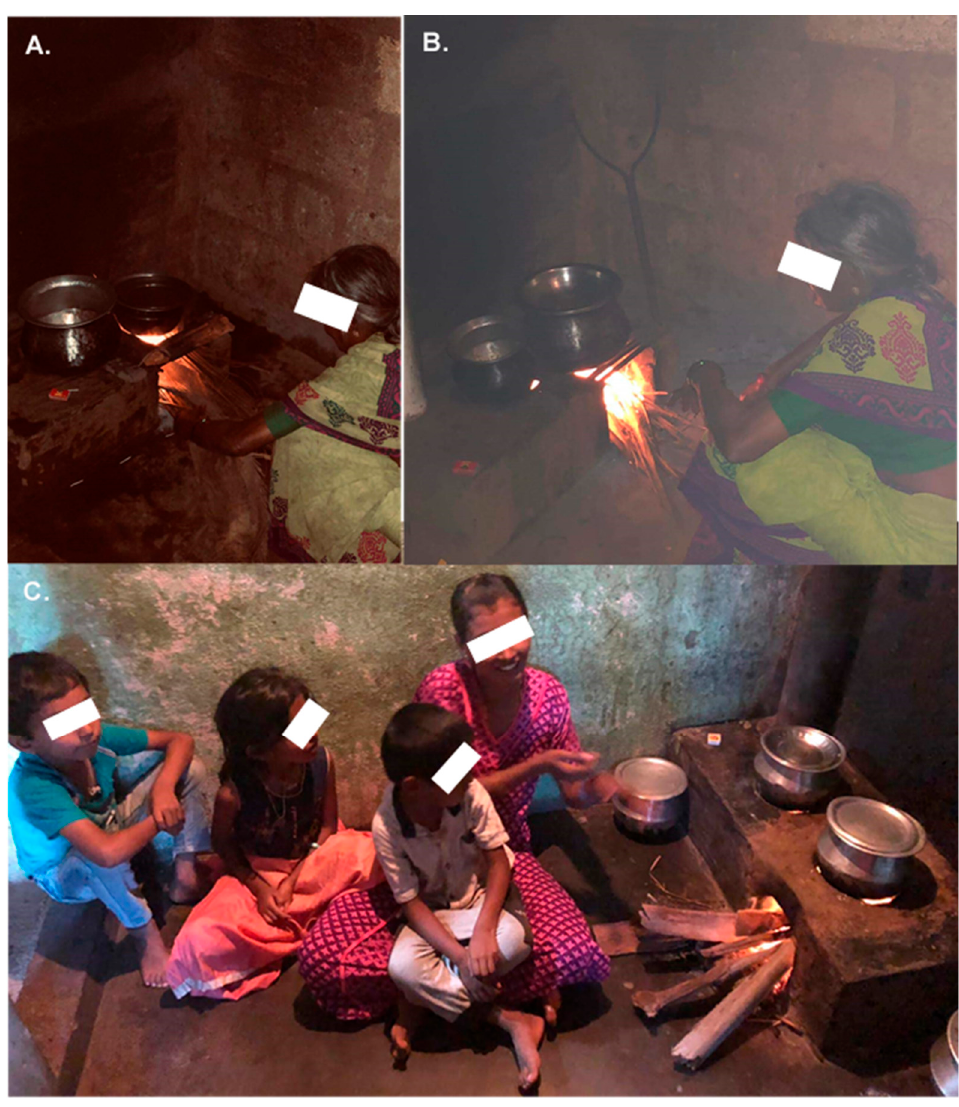
Figure 1. Representative pictures from field studies in Mysuru, Karnataka, India showing biomass smoke exposure among women and children during cooking. ( A ) At the start of cooking when the air is relatively cleaner. ( B ) 15 min after the start of cooking and this remains for at least 1 h after cooking. Usual cooking time is about 1–1.5 h. ( C ) Children along with mother are exposed to biomass smoke during cooking.